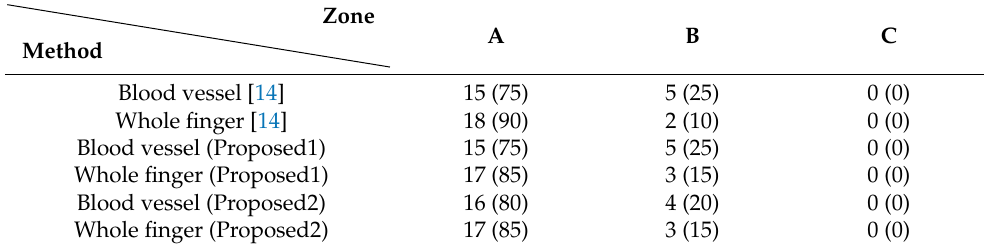
Table 5. EGA-based comparison between this study and the previous study.